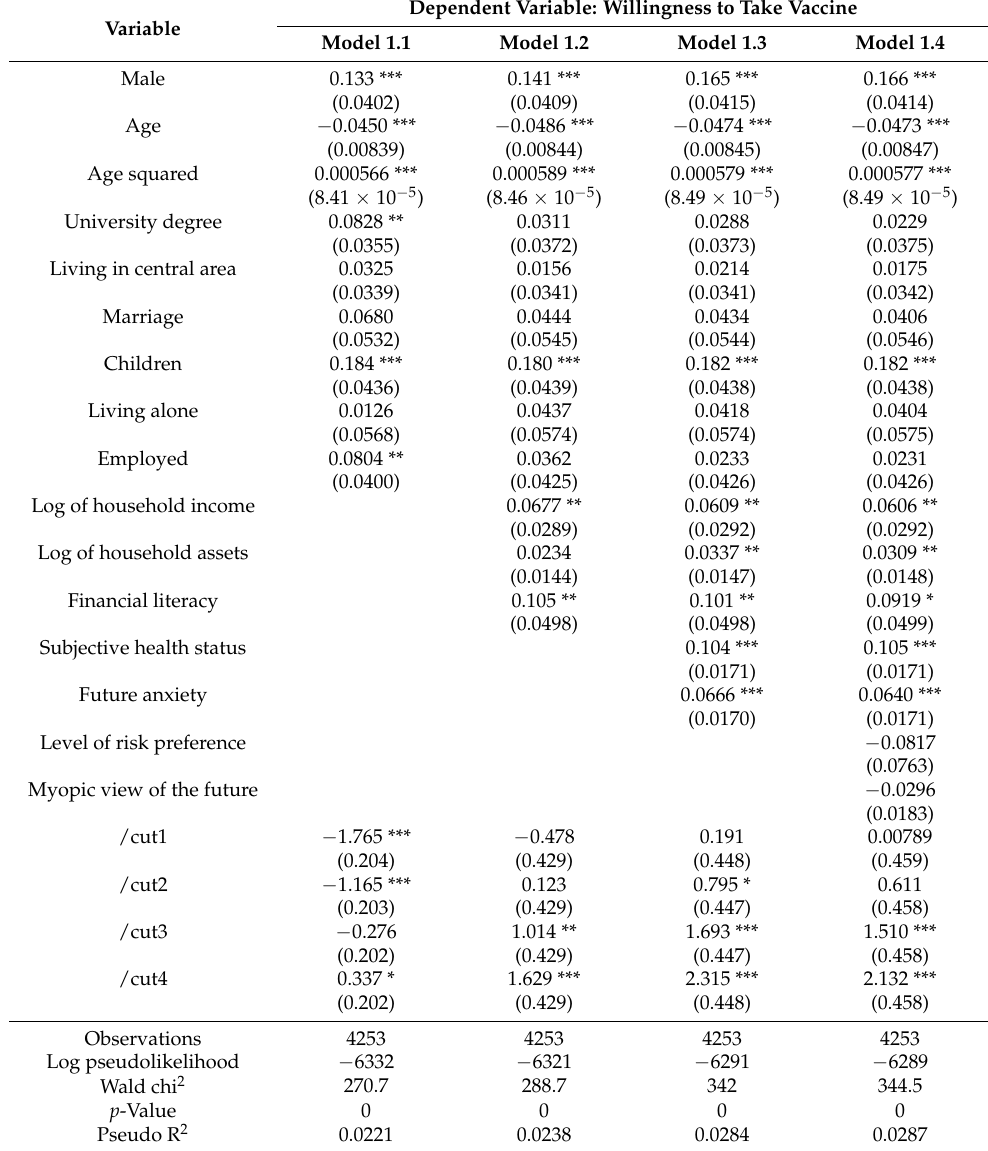
Table 5. Ordered probit model regression results (full sample